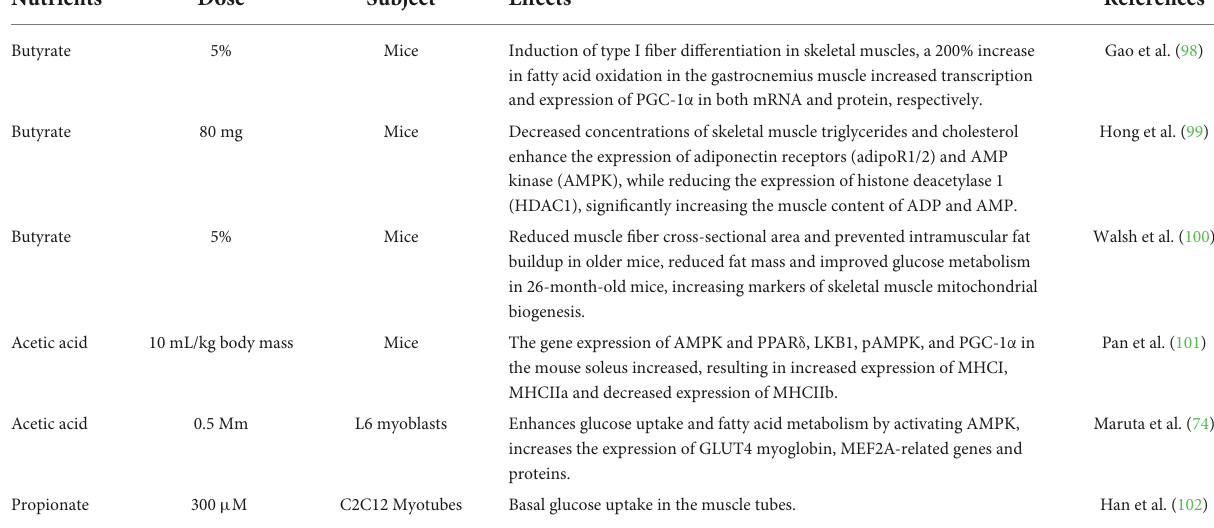
TABLE 1 Key nutrients regulate muscle fiber